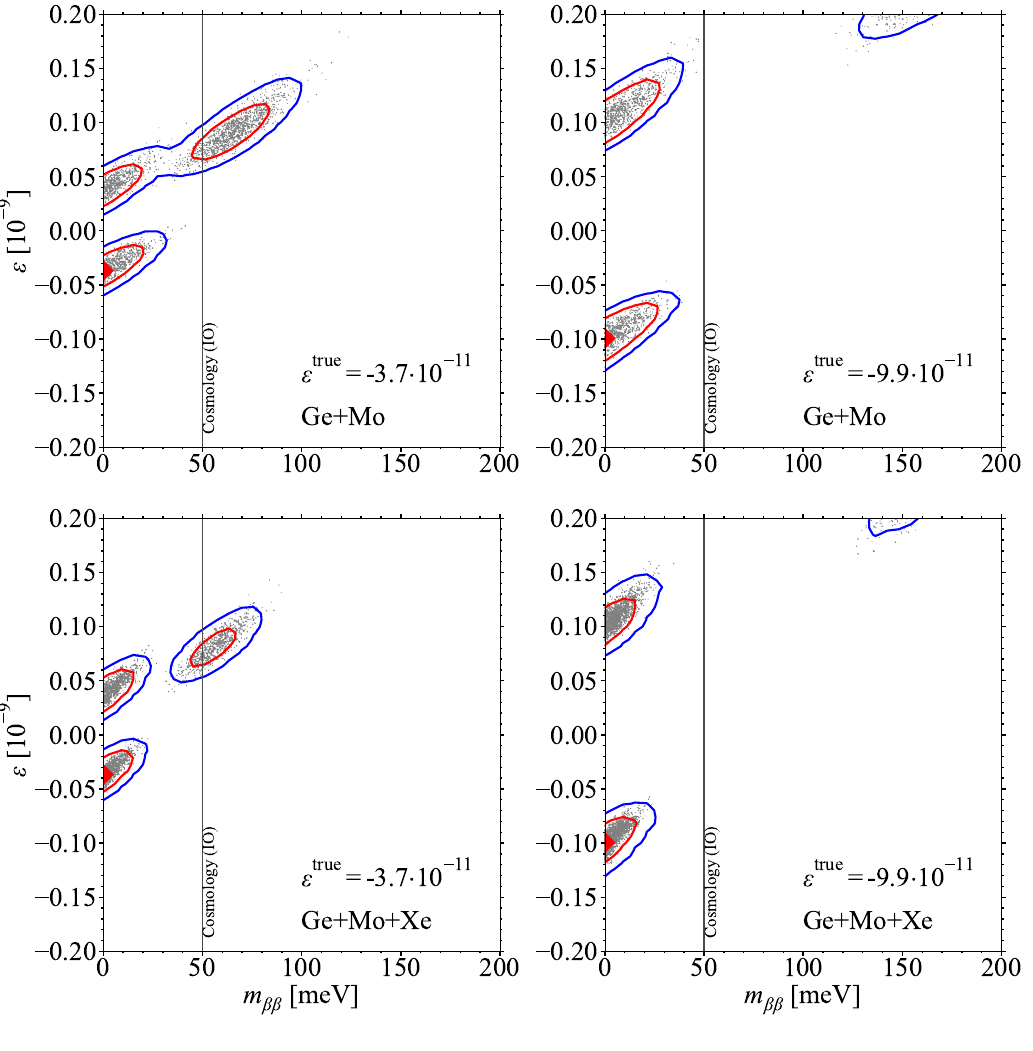
Figure 9 . As figure 8 but with ten-times narrower NME probability